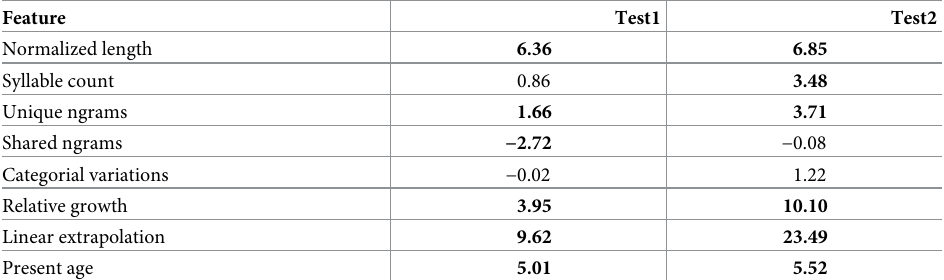
Table 8. The F-score of each feature alone minus the F-score of random guessing. Numbers that are statistically sig- nificant with 95% confidence are marked in bold. Positive numbers indicate that a feature is better than random guessing.